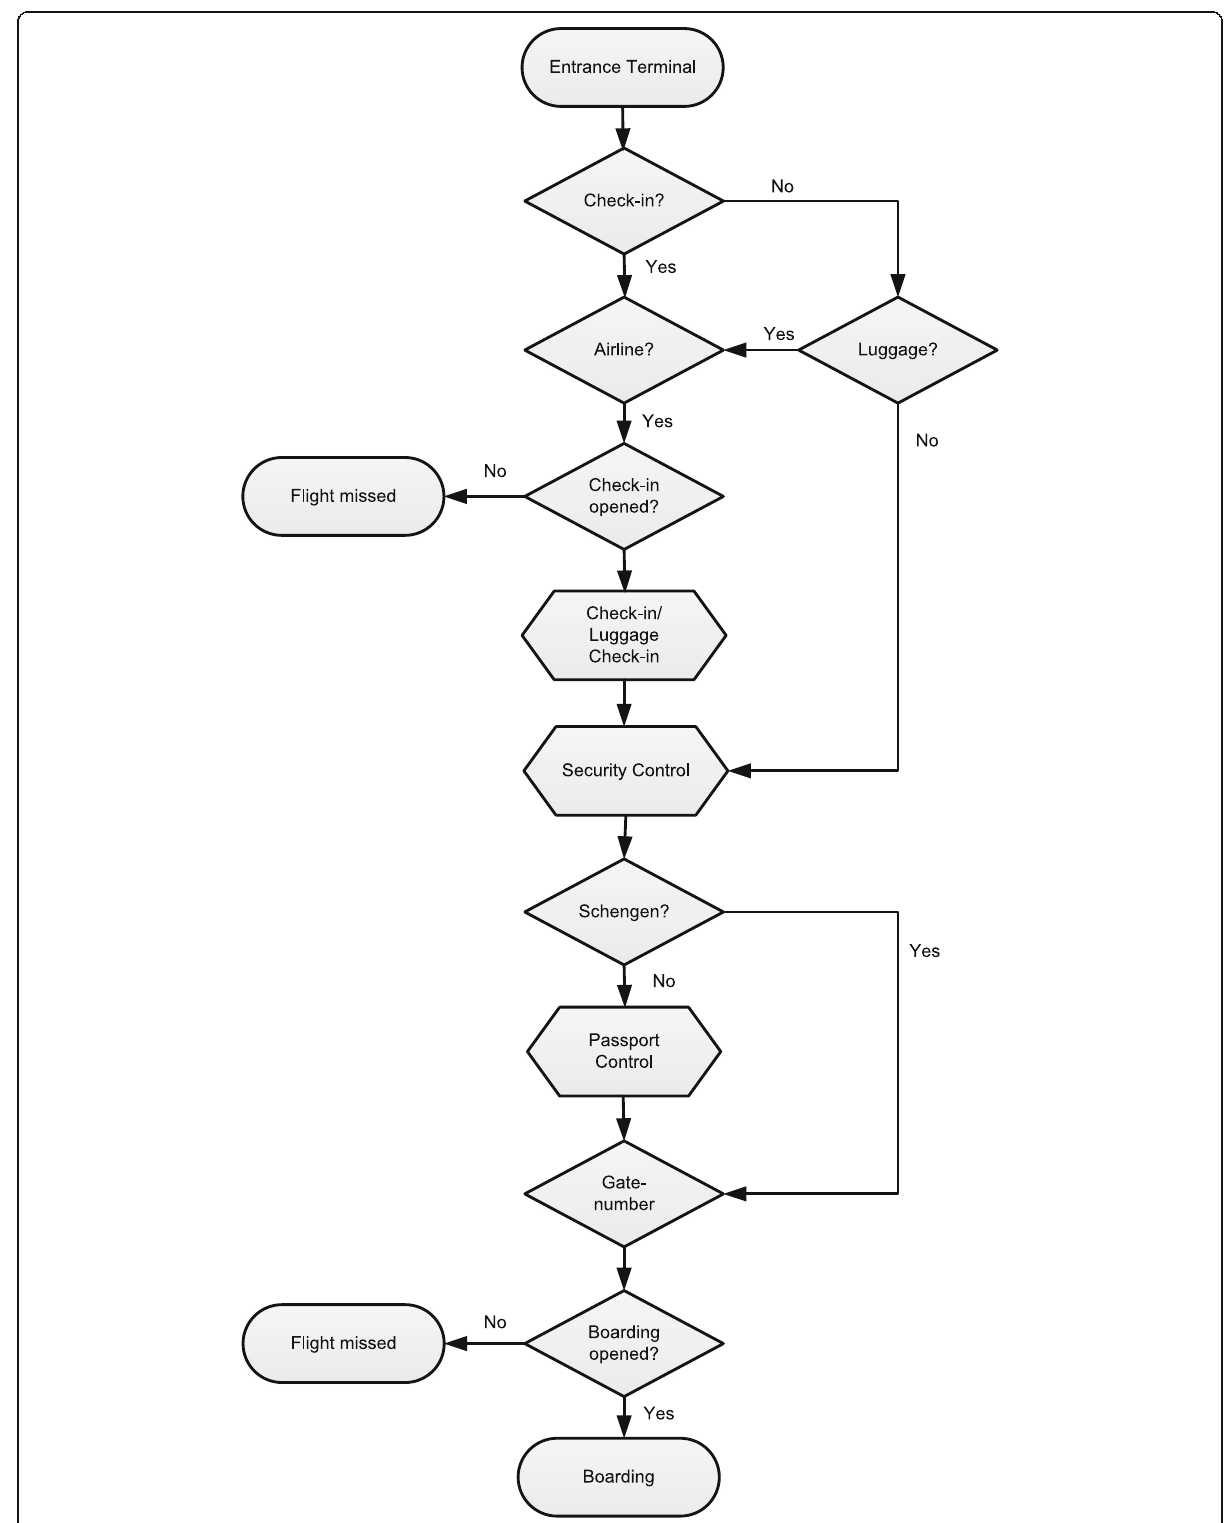
Fig. 2 Simulation logic for the departure processes. Ellipses show situations where passengers enter and leave the airport, service stations are represented by hexagons and diamonds outline chance nodes, that allocate passengers according to different criteria and